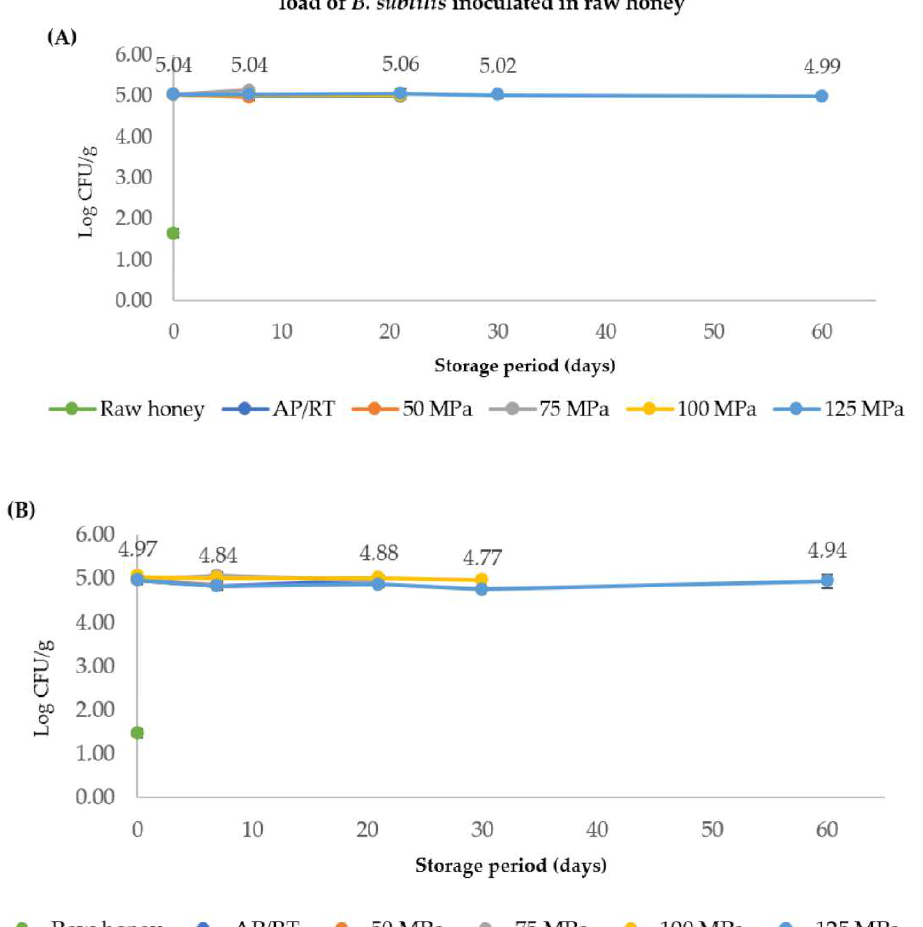
Figure 3. Effects of hyperbaric storage at 50, 75, 100, and 125 MPa at room temperature (20–23 ◦ C): ( A ) on the total B. subtilis microbial load (vegetative and endospores cells) in honey, and ( B ) on the B. subtilis endospores (after heat-shock at 80 ◦ C for 20 min). AP/RT regards control samples stored at the same room temperature (20 ◦ C) but at atmospheric pressure, while raw honey regards the indigenous B. subtilis load and endospores naturally present in honey.